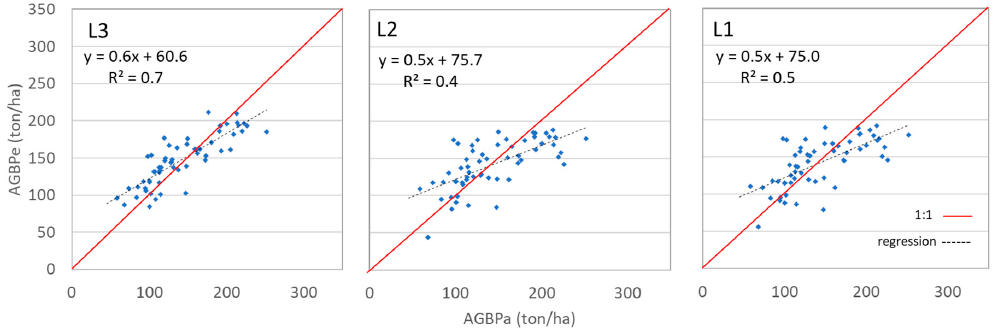
Figure 8. WaPOR-derived AGBPe for L3 (left), L2 (middle), and L1 (right) compared against AGBPa.